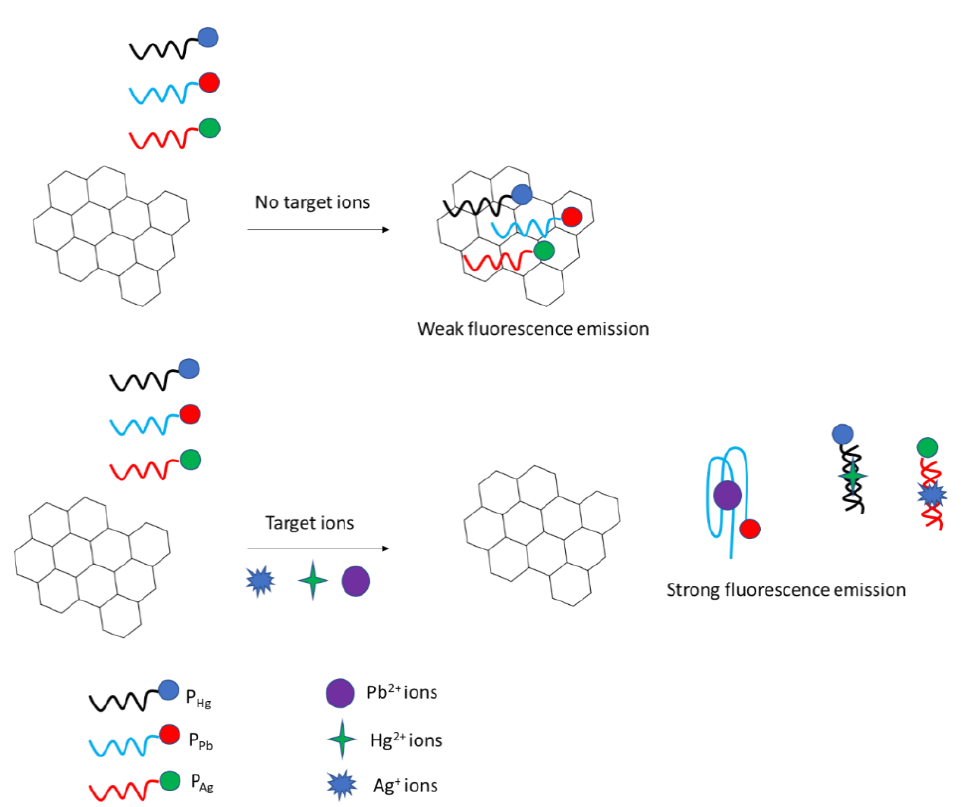
Figure 30. A fluorescent biosensor for detection of lead, mercury and silver ions.